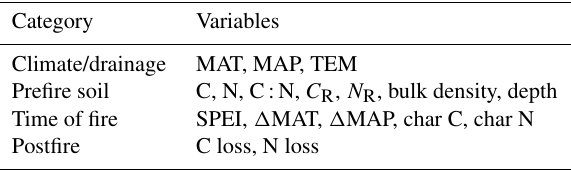
Table 2. Main variables used in path diagram construction listed and grouped by category. Each category row is assumed to have a potential causal effect on lower